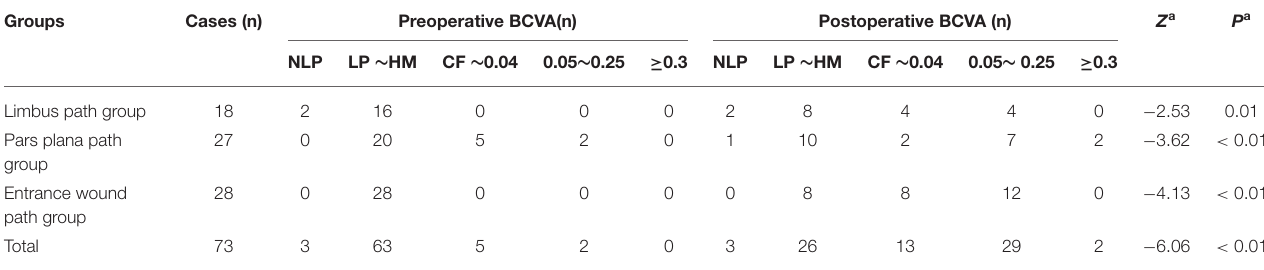
TABLE 2 | Comparison of the preoperative and postoperative BCVAs for all and each giant IOFB extraction path. Groups Cases